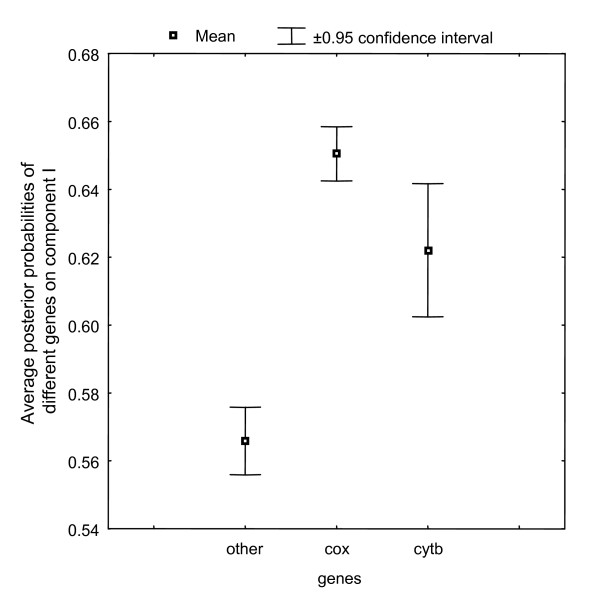
Whiskers plot for the average posterior probabilities of component I for the two-component MBL model on the mitochondrial mammal dataset. A Kruskal-Wallis non-parametric test shows the means of posterior probabilities for genes are significantly different (p < 0.0001)